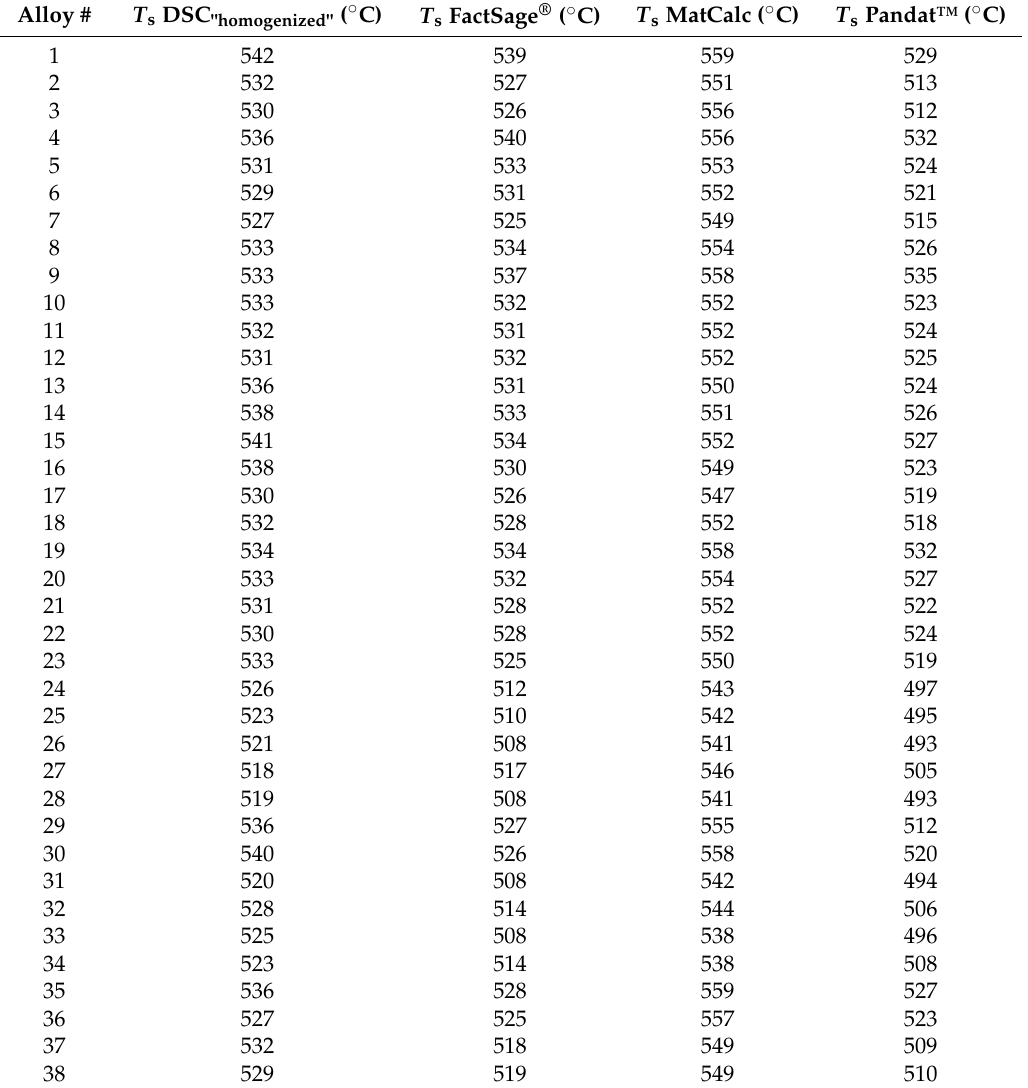
Table 2. Measured and calculated solidus